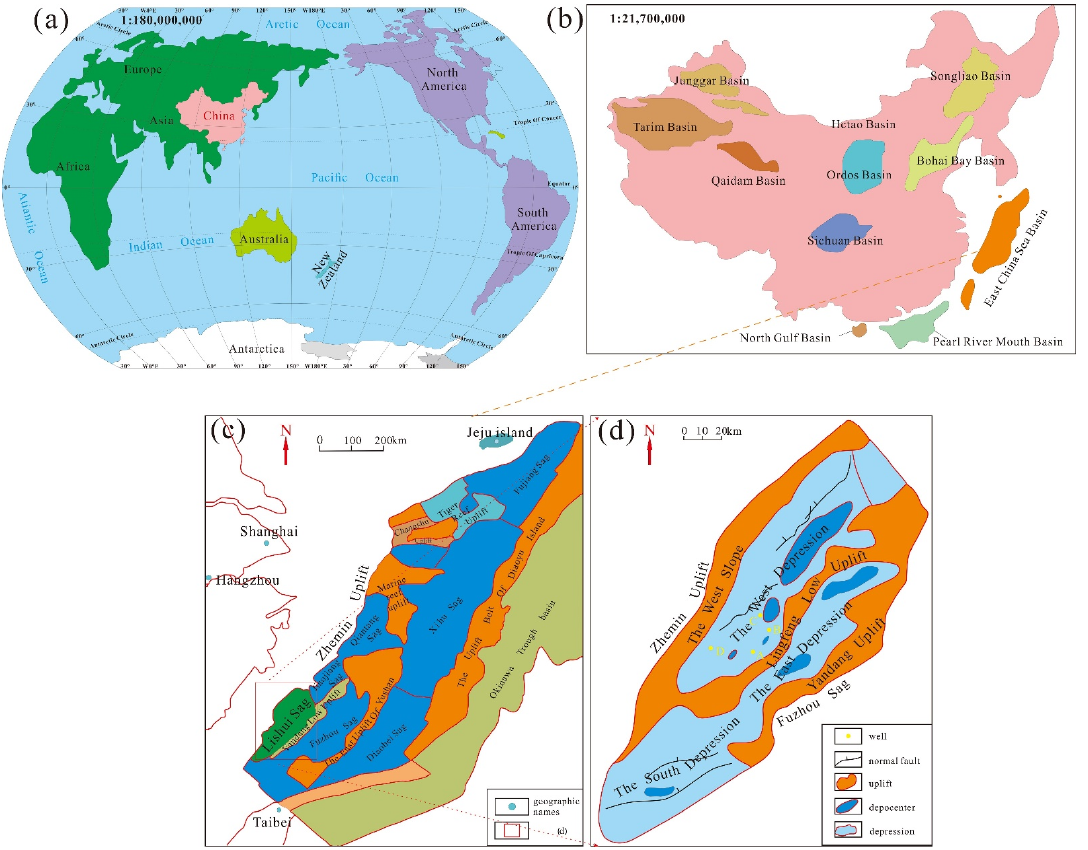
Figure 1. The location of the East China Sea Shelf Basin. ( a ) The location of China; ( b ) The distribution of basins in China; ( c ) The location of Lishui Sag in East China Sea Shelf Basin; ( d ) The structure of Lishui Sag.